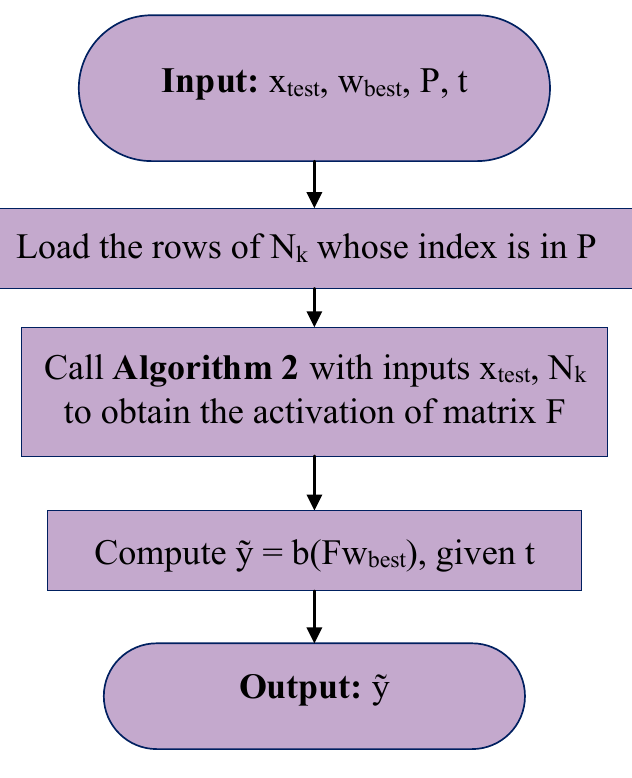
Figure 3. Flowchart for the testing process of the